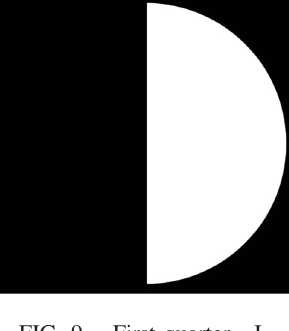
FIG. 12. Waxing crescent.FIG. 9. First quarter — I.